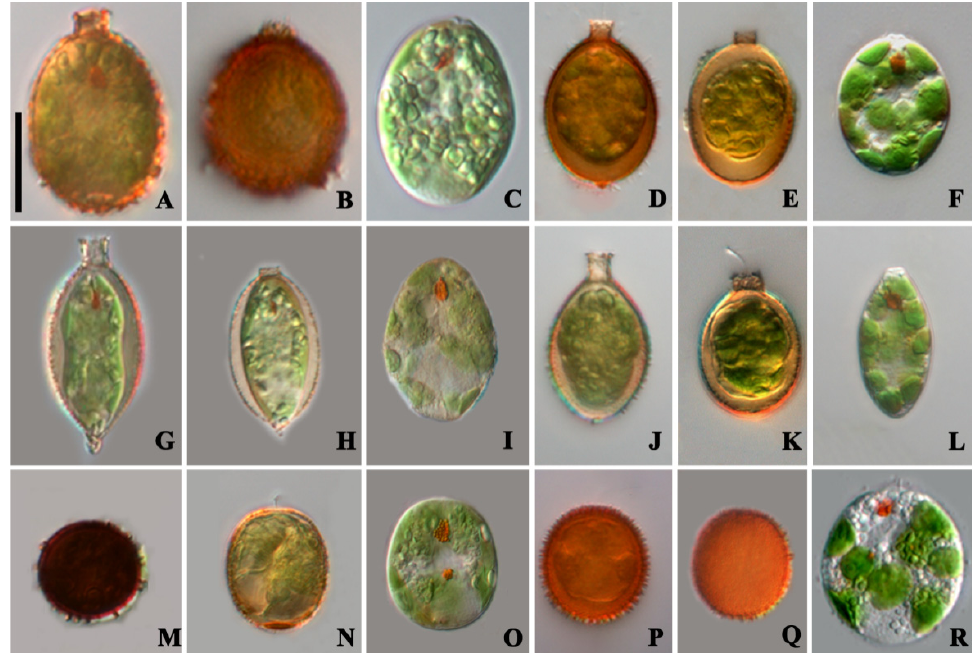
Figure 2. Morphology of Trachelomonas strains in this study. Each species includes: the morphology of lorica in the field (left), morphology of lorica in culture (middle), protoplast morphology (right); ( A – C ) T. cf. crebea strain SHNUS39B2; ( D – F ) T. subplanctonica strain SHNUS17C2; ( G – I ) T. bernardinensis strain SHNUWeijian; ( J – L ) T. undulaticollum strain SHNUS35D5; ( M – O ) Trachelomonas sp. strain SHNUC4C3; and ( P – R ) T. cf. bacillifera var. minima strain SHNUQ4B2. Species are all in the same scale, scale bar 20 μ m.